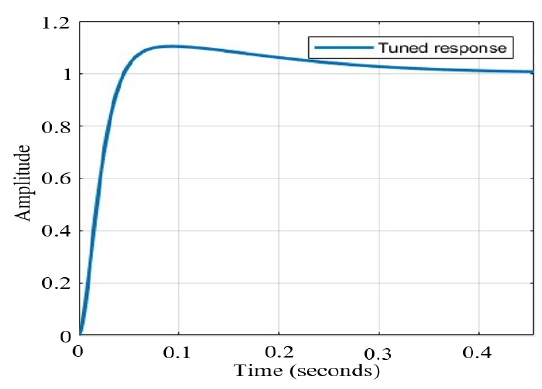
Figure 18. The tuned response curve.